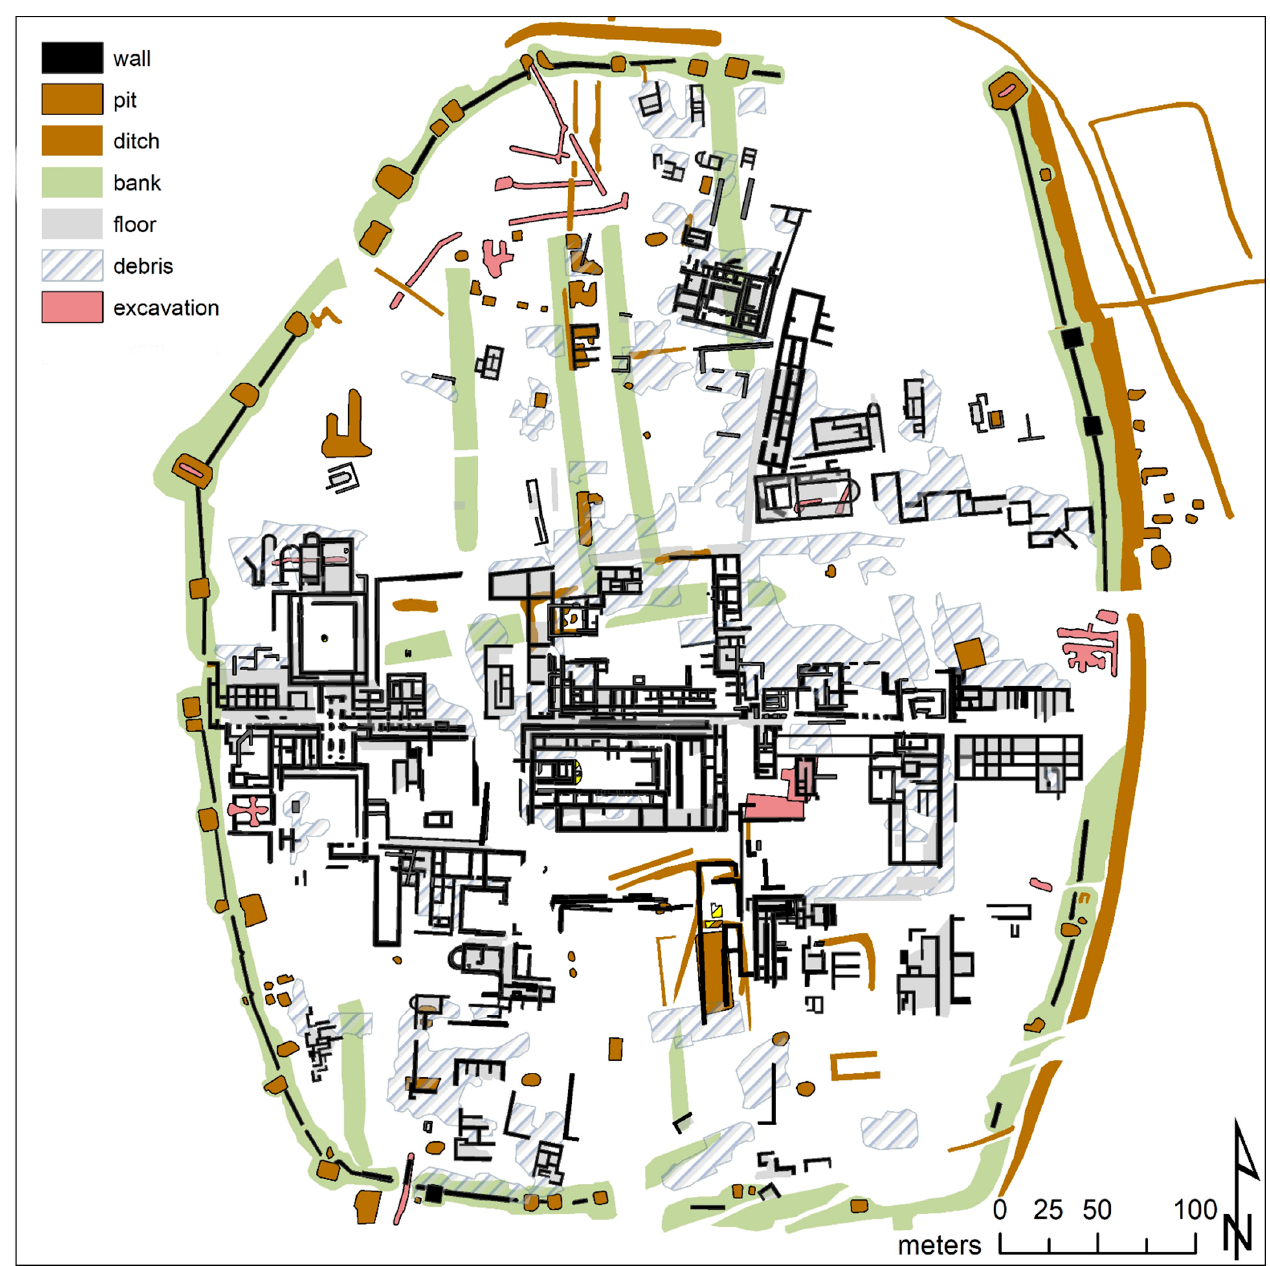
Figure 17. Interpretative map showing the result of the integrated archaeological interpretation of all three datasets.